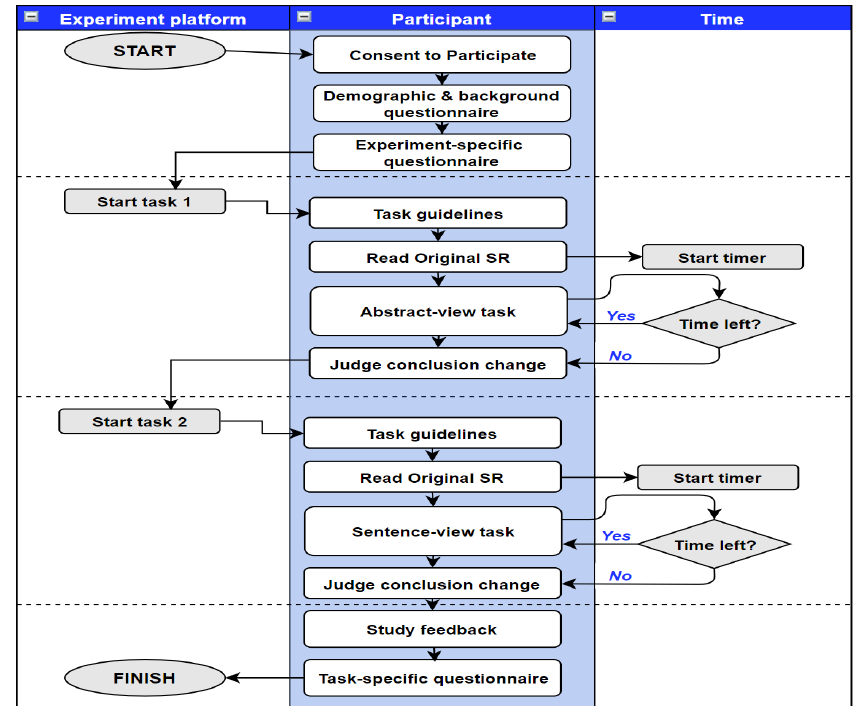
Figure 2. Process flow diagram for both tasks of the